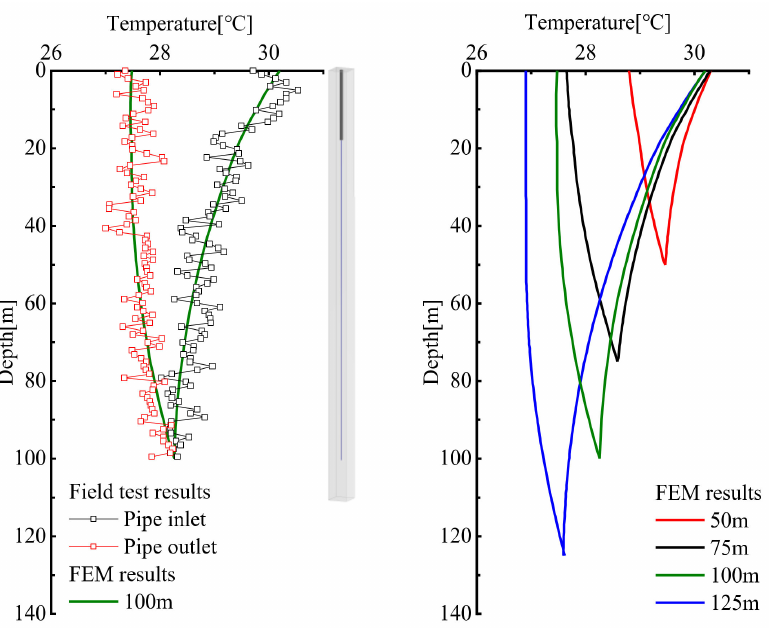
Figure 7. Temperature distribution of #2 pile heat exchange pipe along the depth direction (5.5 kW, 1.0 m 3